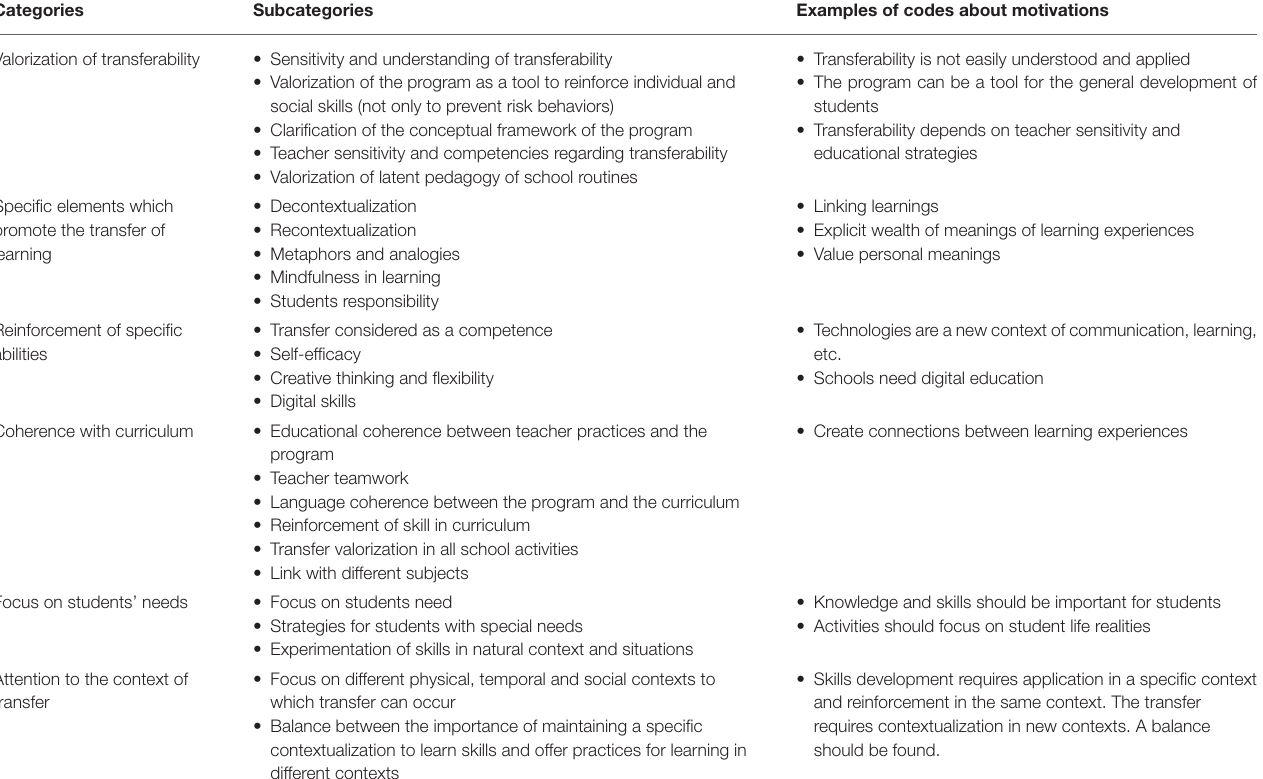
TABLE 3 | Conditions or characteristics of the LST program that should be reinforced to facilitate the transfer.